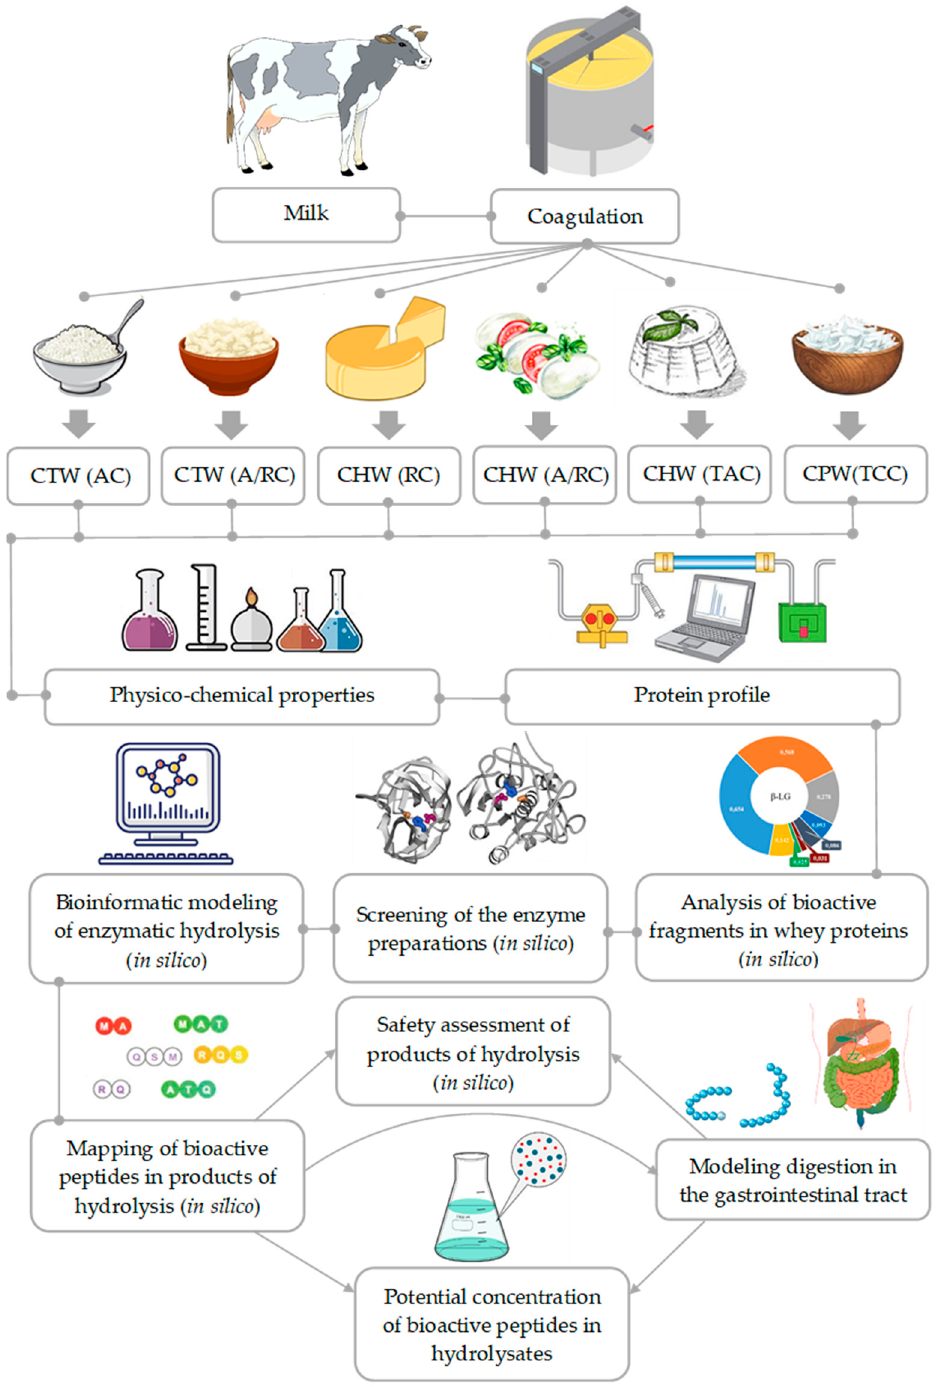
Figure 1. The experimental design .